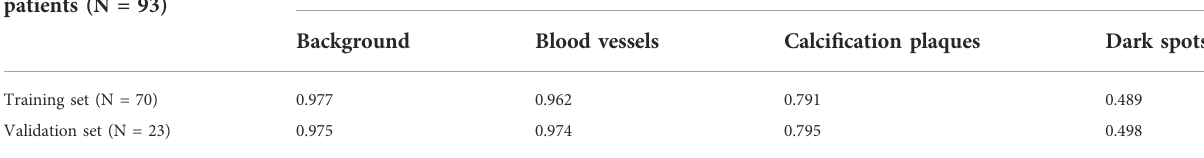
TABLE 2 The performance of the nnU-Net model.